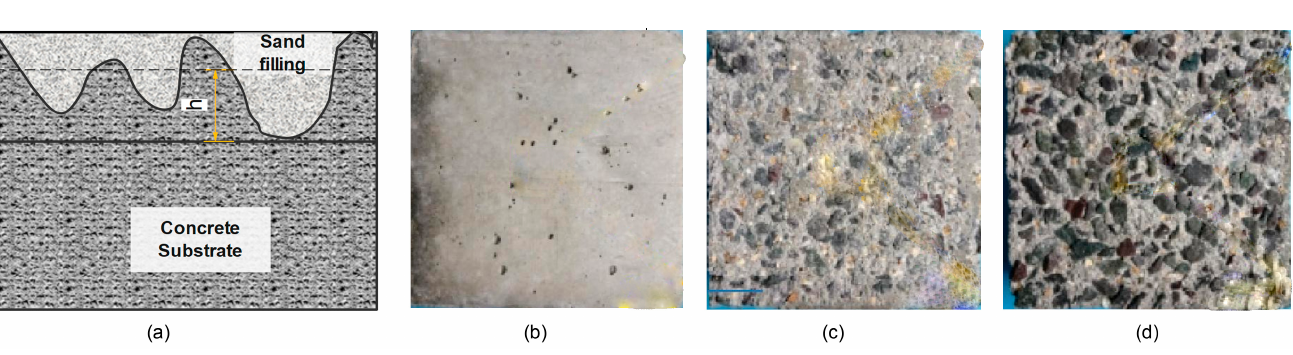
Figure 4. Surface roughness of the concrete substrate: ( a ) sand-filling method; ( b ) smooth surface (no sand filling, h = 0 mm); ( c ) mid-rough surface (sand filling depth of 0.64 mm); and ( d ) rough surface (sand filling depth of 1.29 mm) .